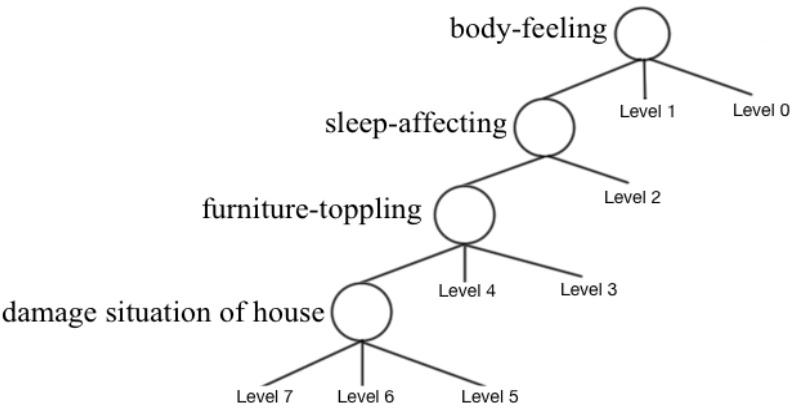
Figure 3. The decision tree model structure.